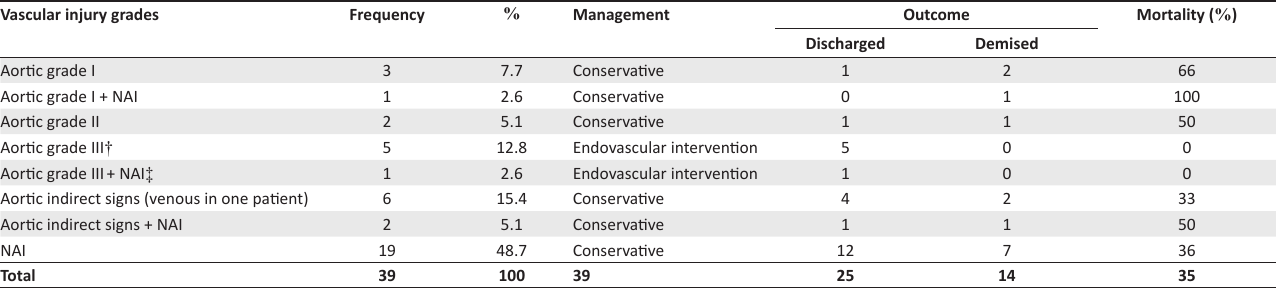
TABLE 3: Summary of vascular injuries, injury combinations, frequencies, management and outcomes. Vascular injury grades